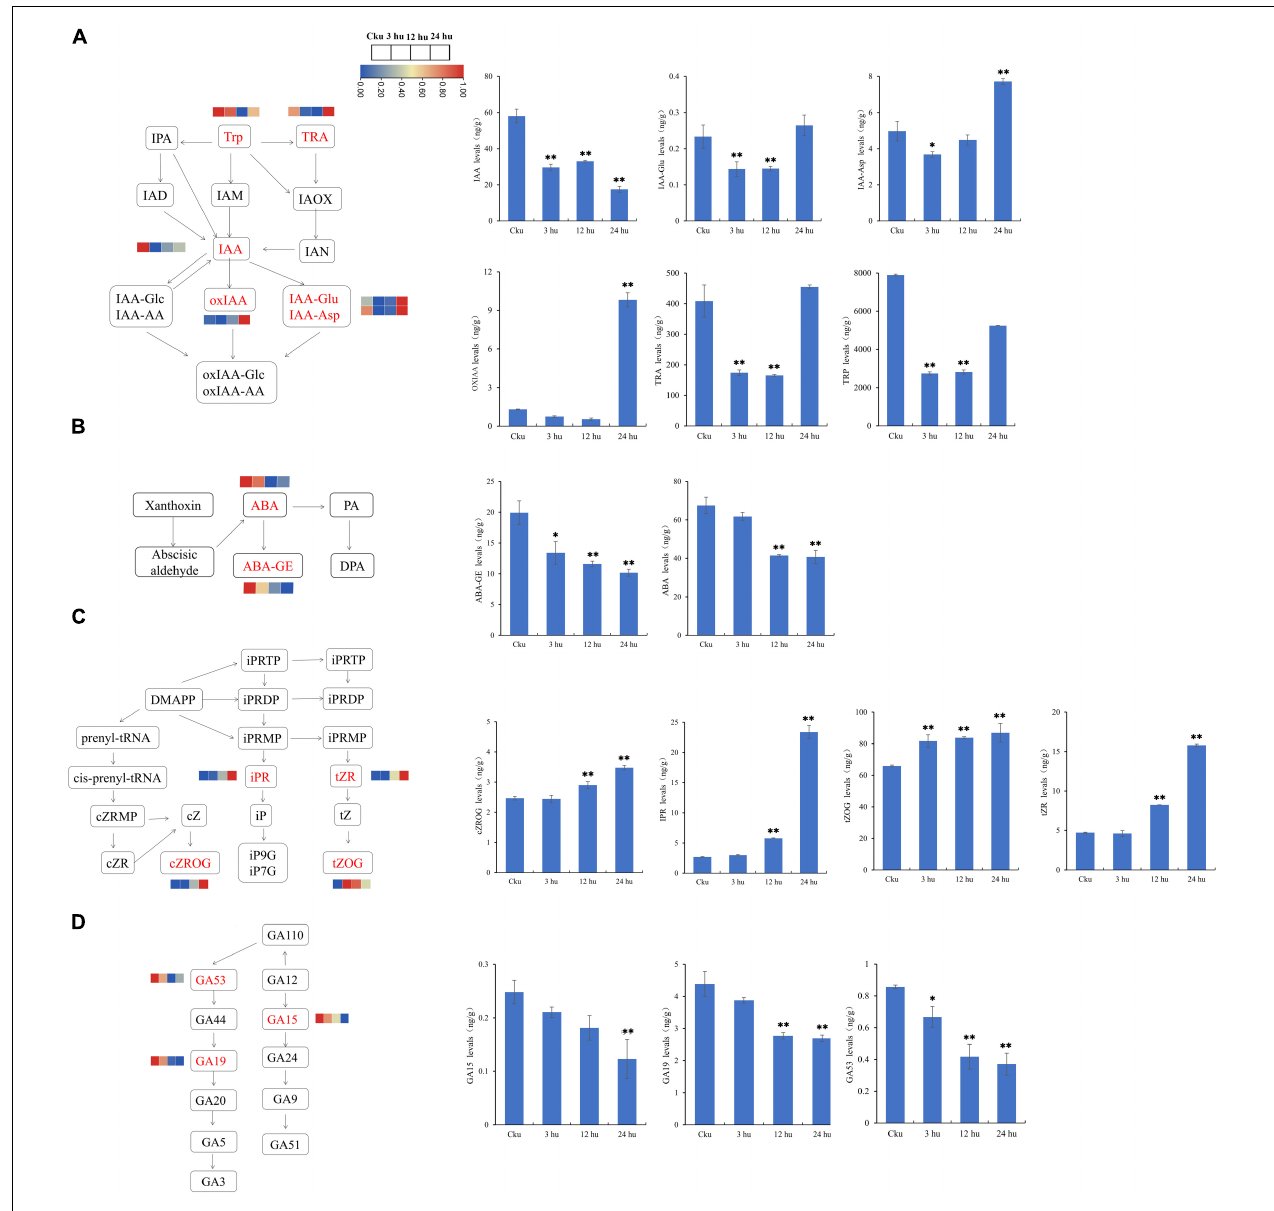
FIGURE 7 | Hormone levels of axillary buds at different positions in un-topped and topped tobacco plants 3, 12, and 24 h after treatment. (A) The auxin biosynthetic pathway and the levels of different auxin components. (B) The abscisic acid biosynthetic pathway and the levels of different abscisic acid components. (C) The cytokinin biosynthetic pathway and the levels of different cytokinin components. (D) The gibberellin biosynthetic pathway and the levels of different gibberellin components. The vertical bars indicate standard error ( n = 3). ∗ P < 0.05, significant correlation; ∗∗ P < 0.01, extremely significant